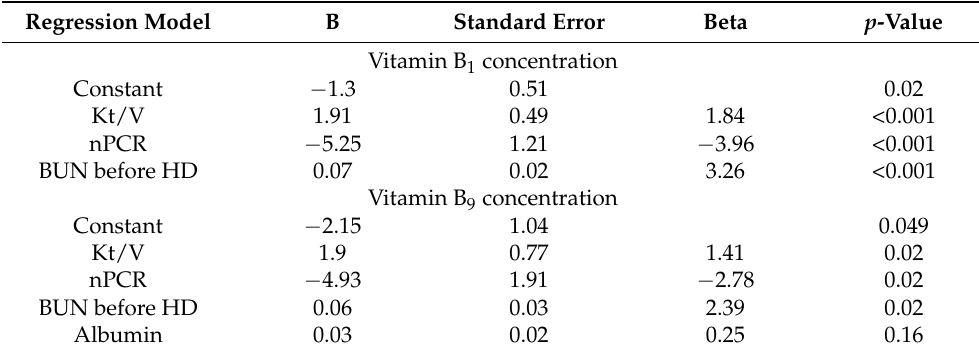
Table 4. Influence of adequacy of dialysis, nPCR, BUN before HD, and albumin level on the concen- tration of vitamins B 1 and B 9 in the blood of HD